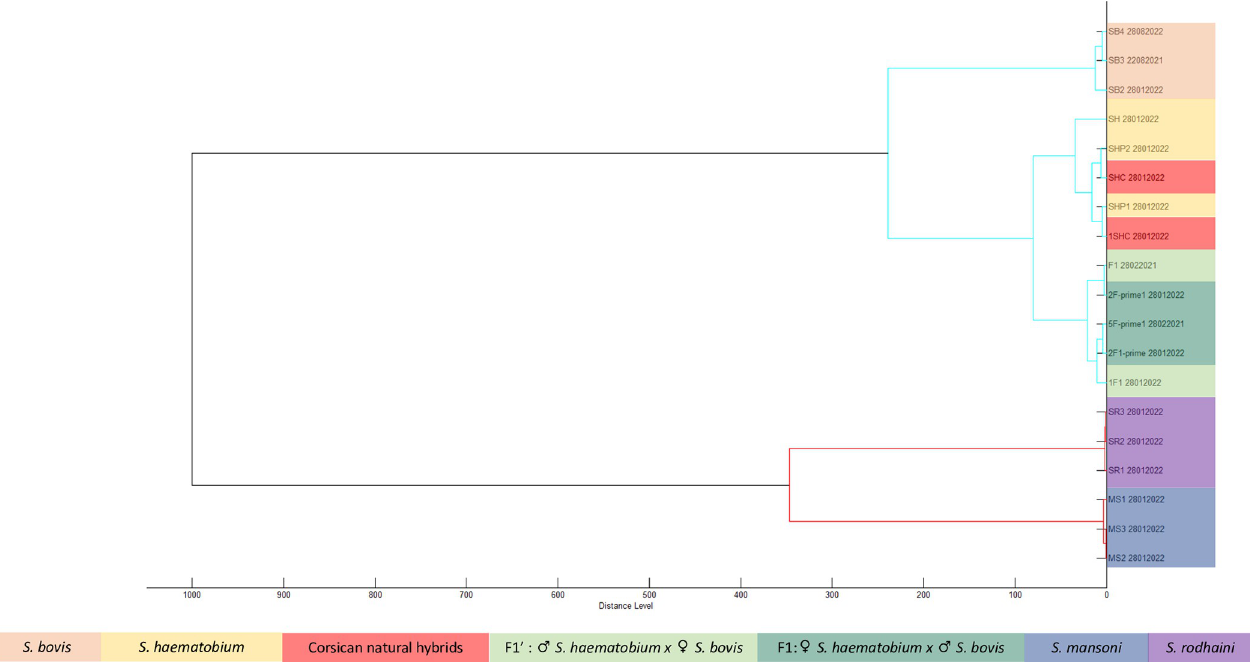
Fig 2. Cluster analysis of MSP. Spectra dendrogram was obtained using Pearson correlation coefficient and Ward D2 linking.